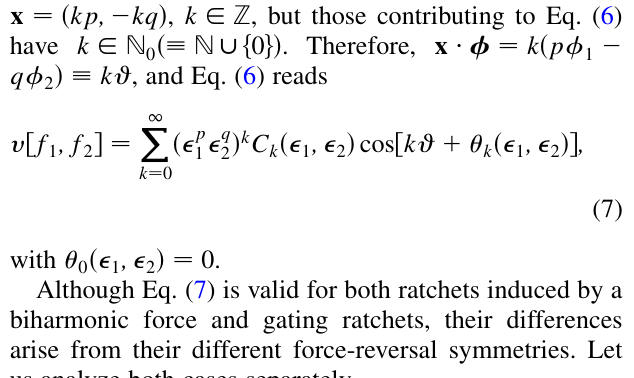
and phase lag (cid:5) as max 1 ¼ (cid:2) of the biharmonic force, 1 2 ð (cid:2) Þ ¼ (cid:1) 0 : 3238 1